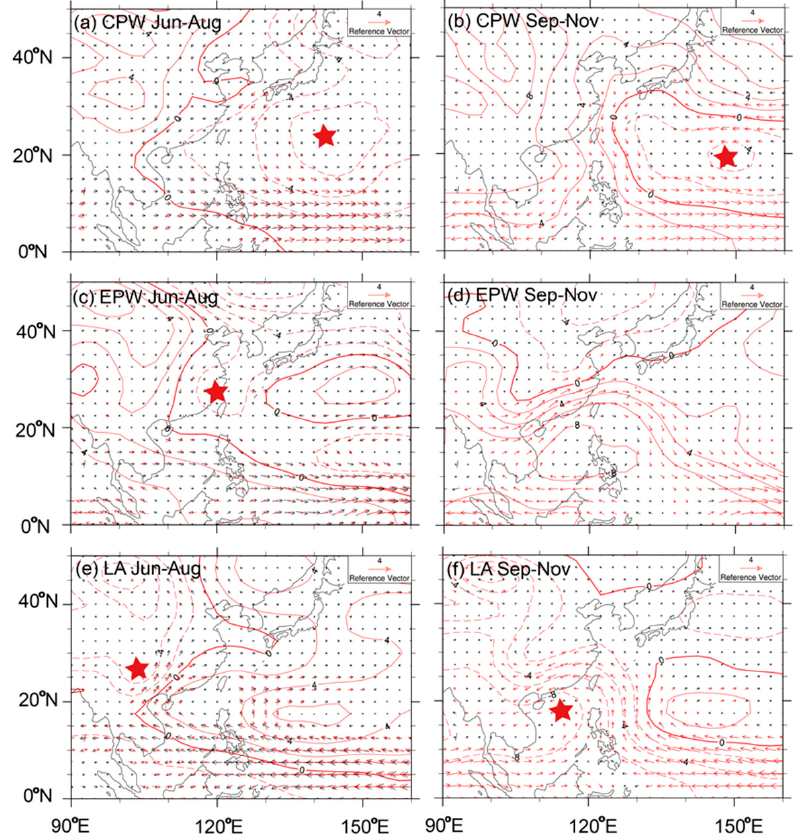
Figure 9. Composite anomalies of the vector wind (vector, m/s) and geopotential height (contour, gpm) at 850 hPa for JJA ( a , c , e ) and SON ( b , d , f ) seasons during CPW ( a , b ), EPW ( c , d ) and La ( e , f ) events. Regions with trends that are significant at 90% confidence are indicated by red arrows, and the center of cyclones are indicated by red pentagram.